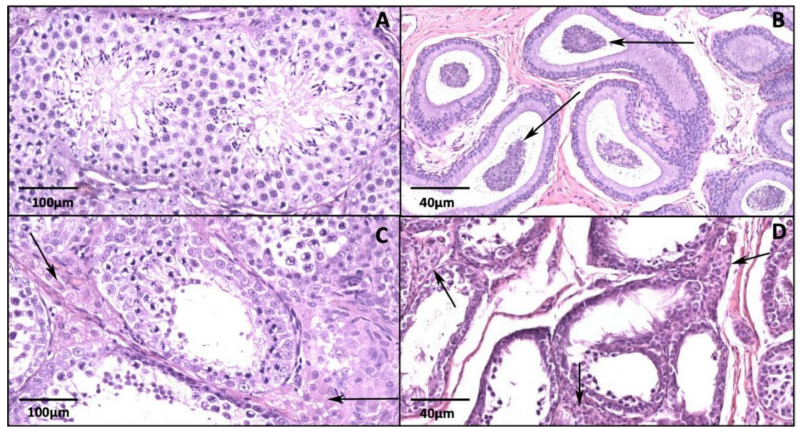
Figure 3. ( A , B ) Testicular histology of a cat treated with a 4.7 mg implant. The implant